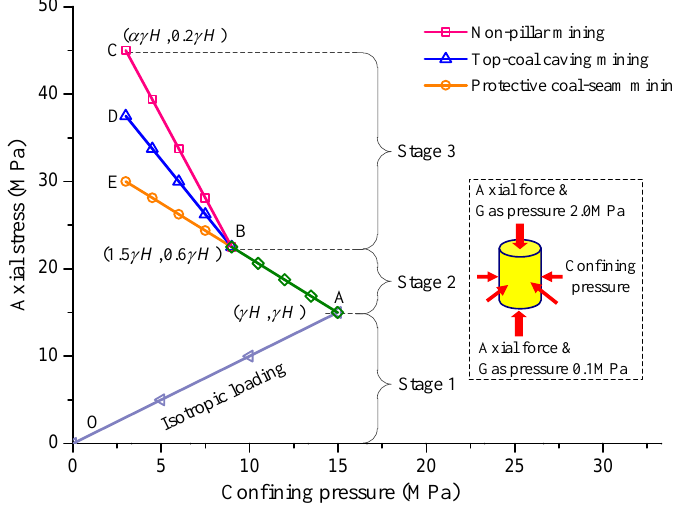
Figure 4. Loading schemes under different mining paths.